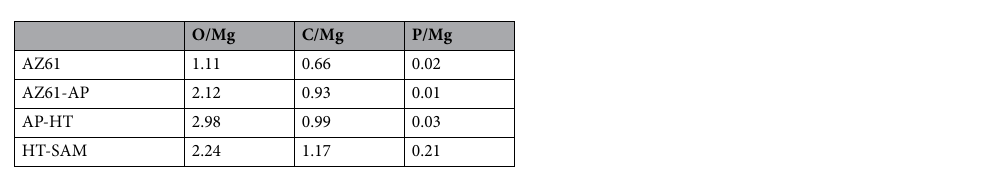
Table 1. Comparison of surface O/Mg, C/Mg and P/Mg atomic ratios for the AZ61 Mg alloy, surface modified AZ61-AP, AP-HT, and HT-SAM